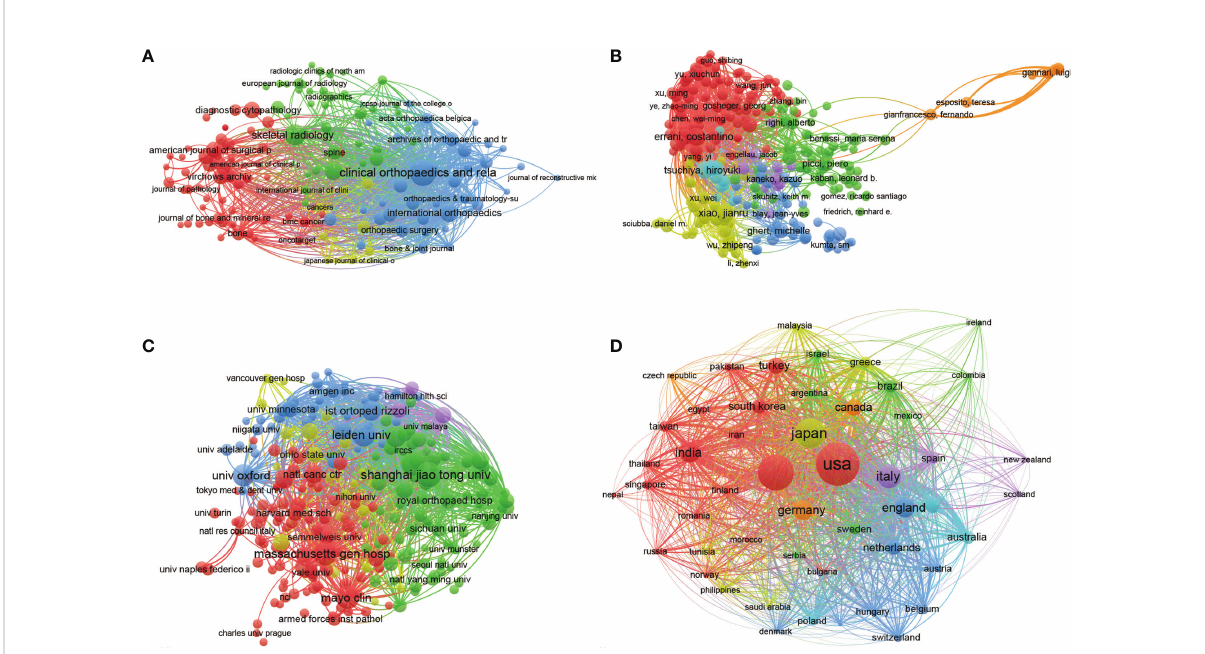
FIGURE 5 Mapping of bibliographic coupling analysis related to GCTB. (A) Mapping of the 134 identi fi ed journals on GCTB. (B) Mapping of the 229 authors on GCTB. (C) Mapping of the 231 institutions on GCTB. (D) Mapping of the 50 countries on GCTB. The line between different points represents that the journals/authors/institutions/countries had established a similarity relationship. The thicker the line, the closer the link between the